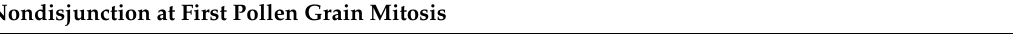
Table 2. Summary of various mechanisms of B accumulation in